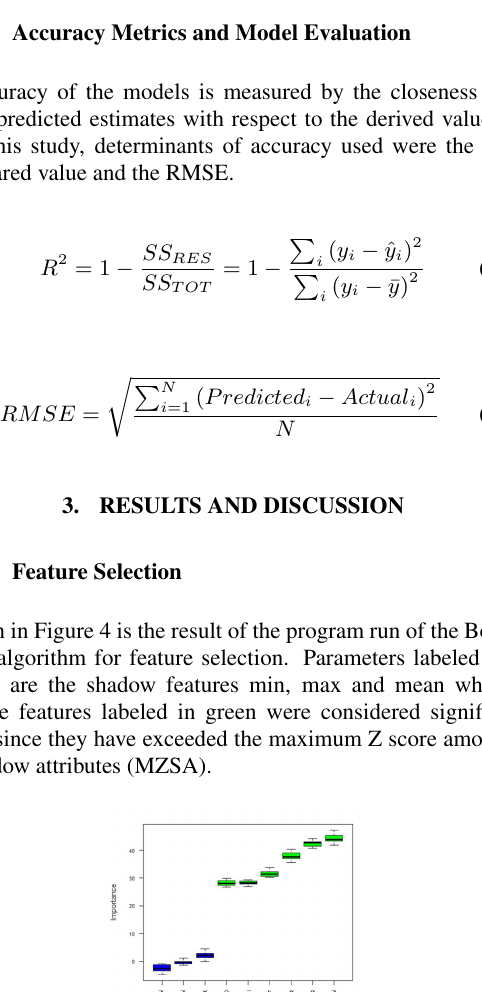
Figure 3. Statistical machine learning algorithms utilized in predictive modeling of LAI.